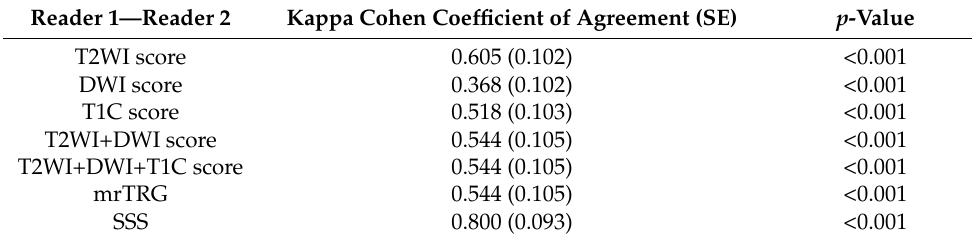
Table 7. Interobserver agreement for restaging MRI in LARC after